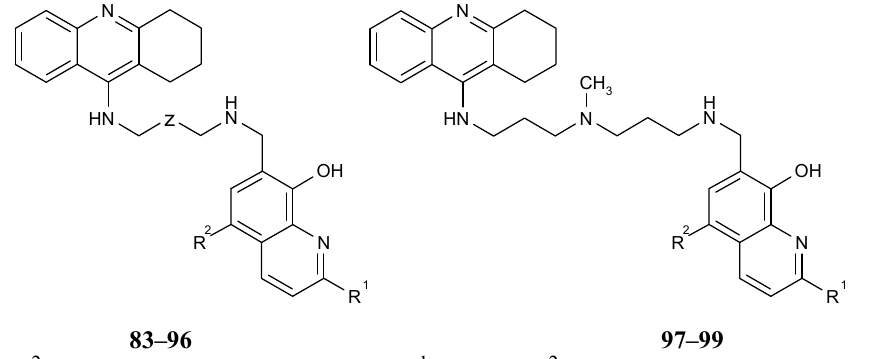
Figure 18. Heterodimeric tacrine-quinoline derivatives 83–99 .